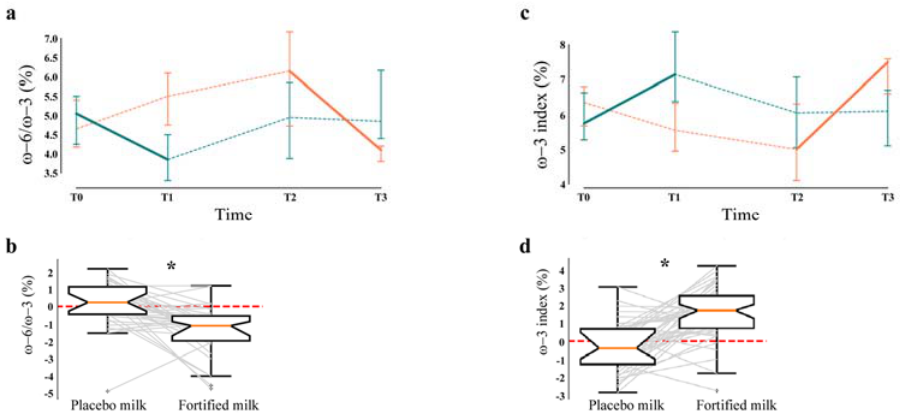
Figure 2. Ratio of ω -6 / ω -3 PUFA and ω -3 index. ( a ) Time-series visualization of ω -6 / ω -3 PUFA ratio in participants of both arms. ( b ) Boxplot of the variation of ω -6 / ω -3 ratio in participants on placebo vs. those on fortified milk is displayed (q < 0.0001 *). ( c ) Time-series visualization of ω -3 index (EPA + DHA content in erythrocytes on total fatty acids) in participants of both arms. ( d ) Boxplot of the variation of ω -3 index in participants on placebo vs. those on fortified milk is displayed (q < 0.0001 *). Statistical analysis was performed by linear mixed e ff ect model and a q-value (corrected p-value for the Benjamini–Hochberg multiple comparisons) < 0.05 was considered statistically significant. FP (green line) = arm: fortified milk and then placebo, PF (orange line) = arm: placebo and then fortified milk, Solid line = fortified milk, Dashed line = placebo milk / washout, DHA = docosahexaenoic acid, EPA = eicosapentaenoic acid.